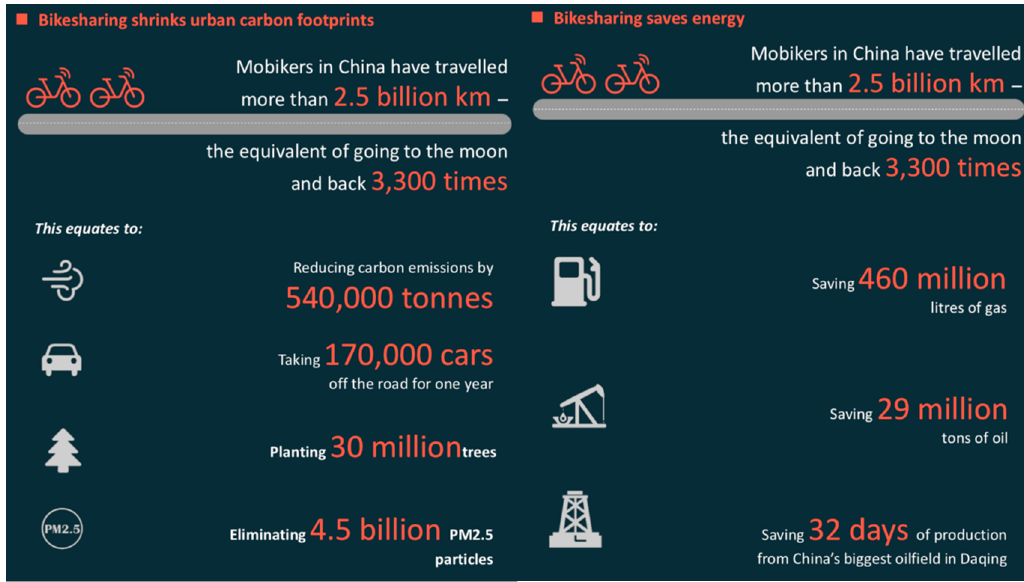
Figure 4. The statistics of bike sharing and its equitation to resource and environment data in Mobike White Paper [25].